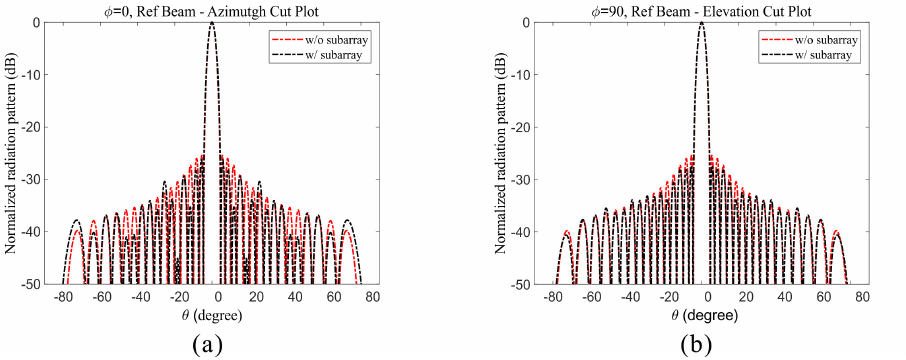
Figure 5. Radiation pattern about the boresight direction at 30 GHz (w/a subarray (96 TRMs) vs.